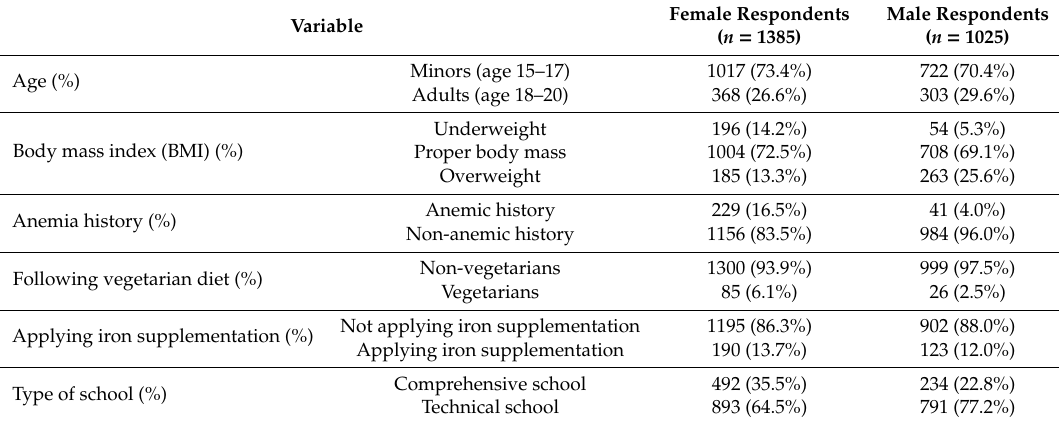
Table 1. The baseline characteristics of the studied